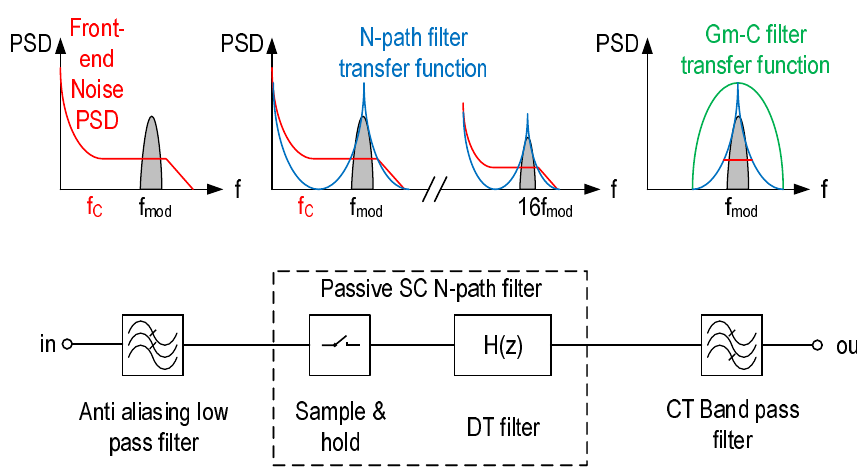
Figure 7. Signal processing block diagram of the readout chain with a spectrum analysis of the